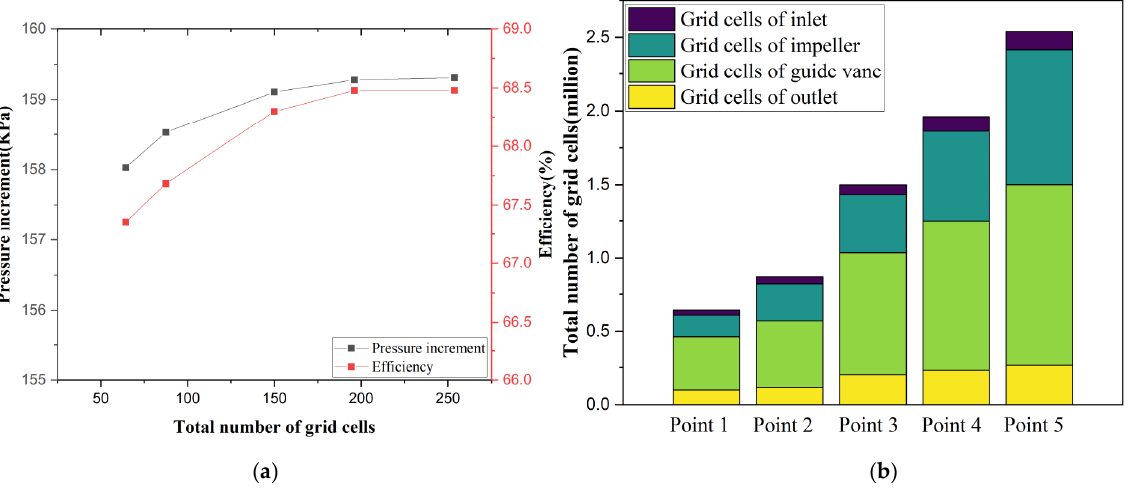
Figure 4. Verification of grid independence for numerical simulation of the multiphase pump. ( a ) Curves of grid number growth with performance parameters; ( b ) comparison of the number of grids in different areas of the multiphase pump.